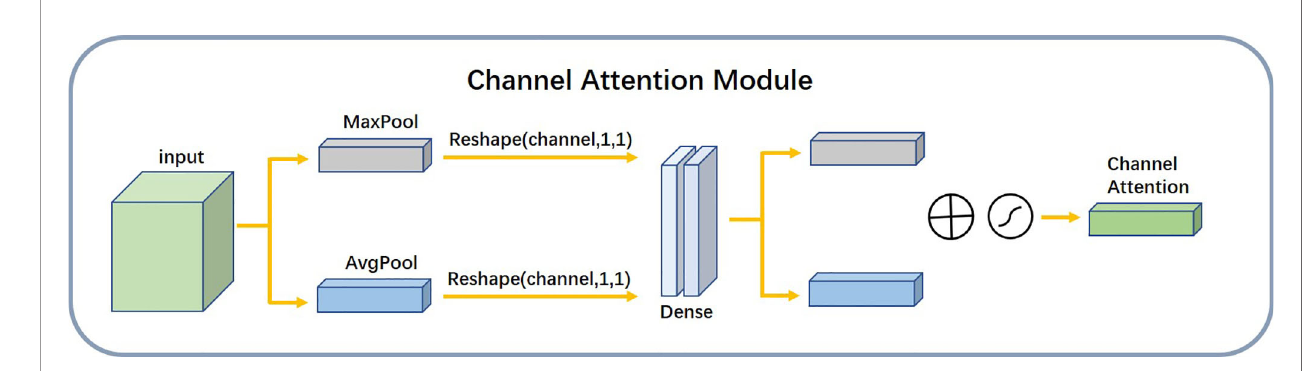
FIGURE 7 | Structure diagram of channel attention module.